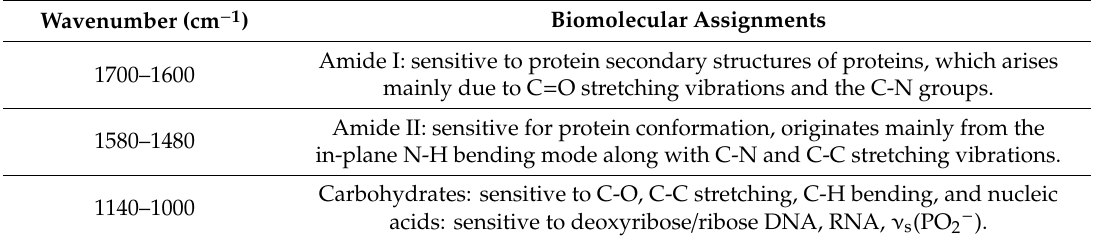
Figure 2. Identification of discriminatory bands. ( A ) Ensemble averages of normalized serum spectra derived from control, n = 10, and BC, n = 10. This wider range of spectra is presented to show the quality of spectra, which overcomes the noise and atmospheric contamination, while measuring them at a resolution of 4 cm -1 . ( B ) Corresponding Student t-test p-values for the control and BC. ( C ) The second derivative absorbance spectra is confined to the amide-I region, covering 1600–1700 cm -1 . ( D ) Difference between the absorbance spectra of the control and BC (shown in Figure 1A), indicating the up- and down-regulation of proteins, carbohydrates, and nucleic acids in the serum of breast cancer patients. Table 1. Discriminatory IR bands for BC serum samples from controls, and primary biomolecular assignments giving rise to the main contributions for the absorbance (taken from [68–74]). Amide regions and the complex region of carbohydrates and nucleic acids show the discriminating potential.